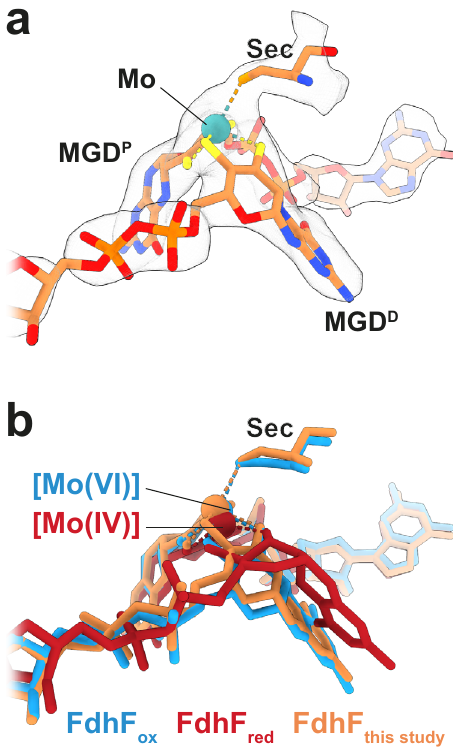
Fig.3|GeometryoftheMo(MGD) 2 cofactor.a Atomicmodelandcryo-EMdensity oftheMo(MGD) 2 cofactorwiththeproximalMGD(MGD P ),distalMGD(MGD D ),and the metal-coordinating selenocysteine (Sec) in subunit FdhF of the aerobically isolated FHL. b Superposition of our aerobically isolated FHL model with crystal structures of oxidized (blue; PDB 1FDO 29 ) and reduced (red; PDB 2IV2 30 ) FdhF. The geometry of MGD D is similar to the crystal structure of FdhF in the oxidized [Mo(VI)] FdhF interacts with HycB and an unpredicted metal ion of HycF Electron transfer between the electron-input module (FdhF) and the primary hydrogenase modules (HycG and HycE) is mediated by the ferredoxin-like proteins HycB and HycF, as predicted from genetic experiments 40 . A loop region between the B3 and B2 [4Fe4S]-